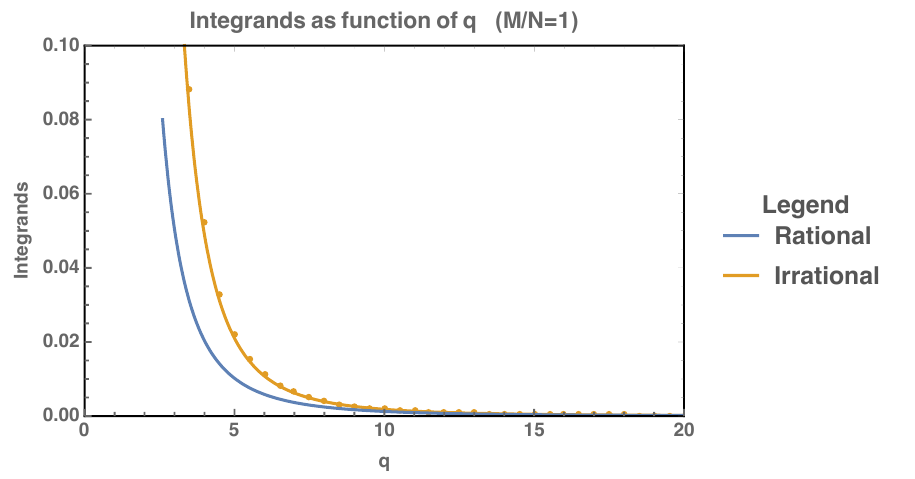
Figure 8. This plot shows the dependence of the integrands at M=N = 1 on the number